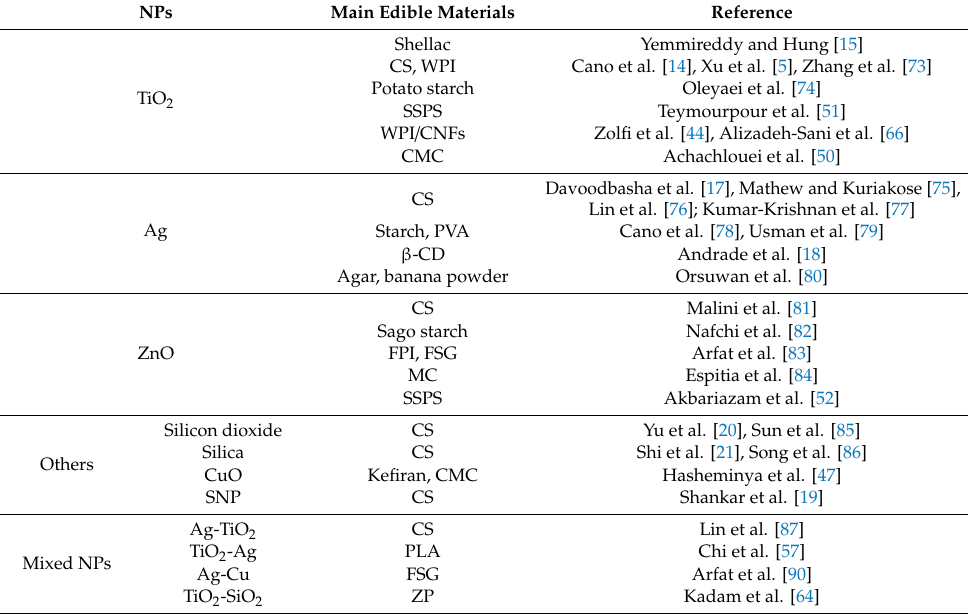
Table 1. Summary of di ff erent NPs and main edible-based materials used in coating films.